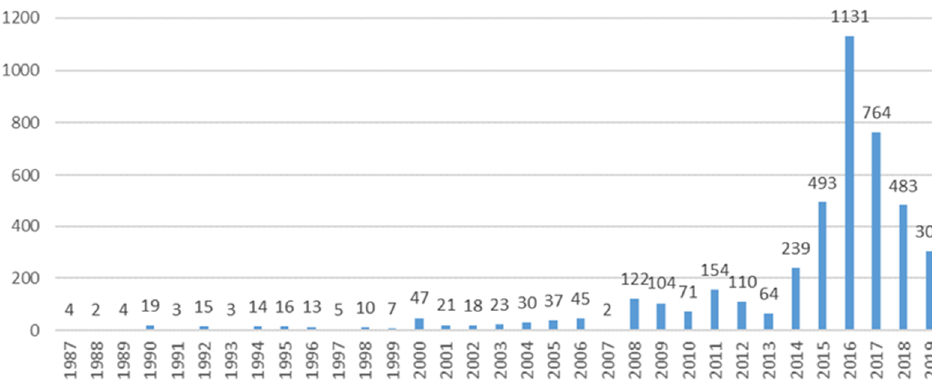
Figure 2. Year trends of reporting .